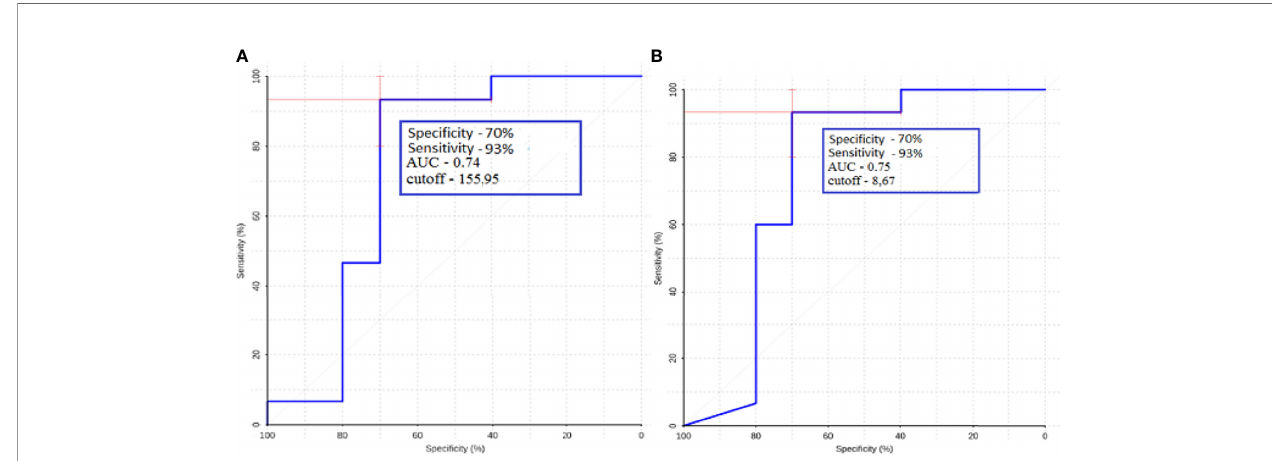
FIGURE 11 | ROC-analysis data obtained when comparing the maximum absolute (A) and normalized (B) values of intratumoral blood fl ow in the groups of metastatic lesions in lung cancer and kidney cancer.